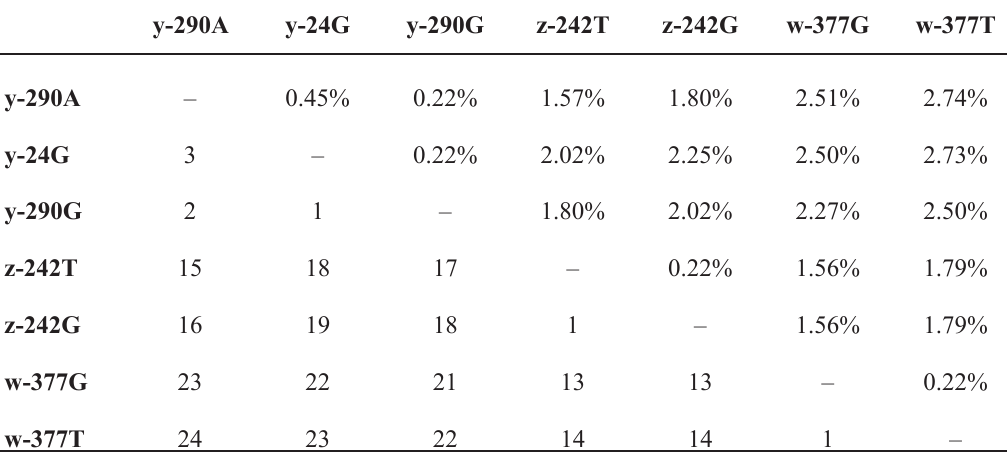
Table 4. Differences below diagonal, counting gaps as fifth state, and genetic distances (HKY85) as percentages above diagonal, between the different i56